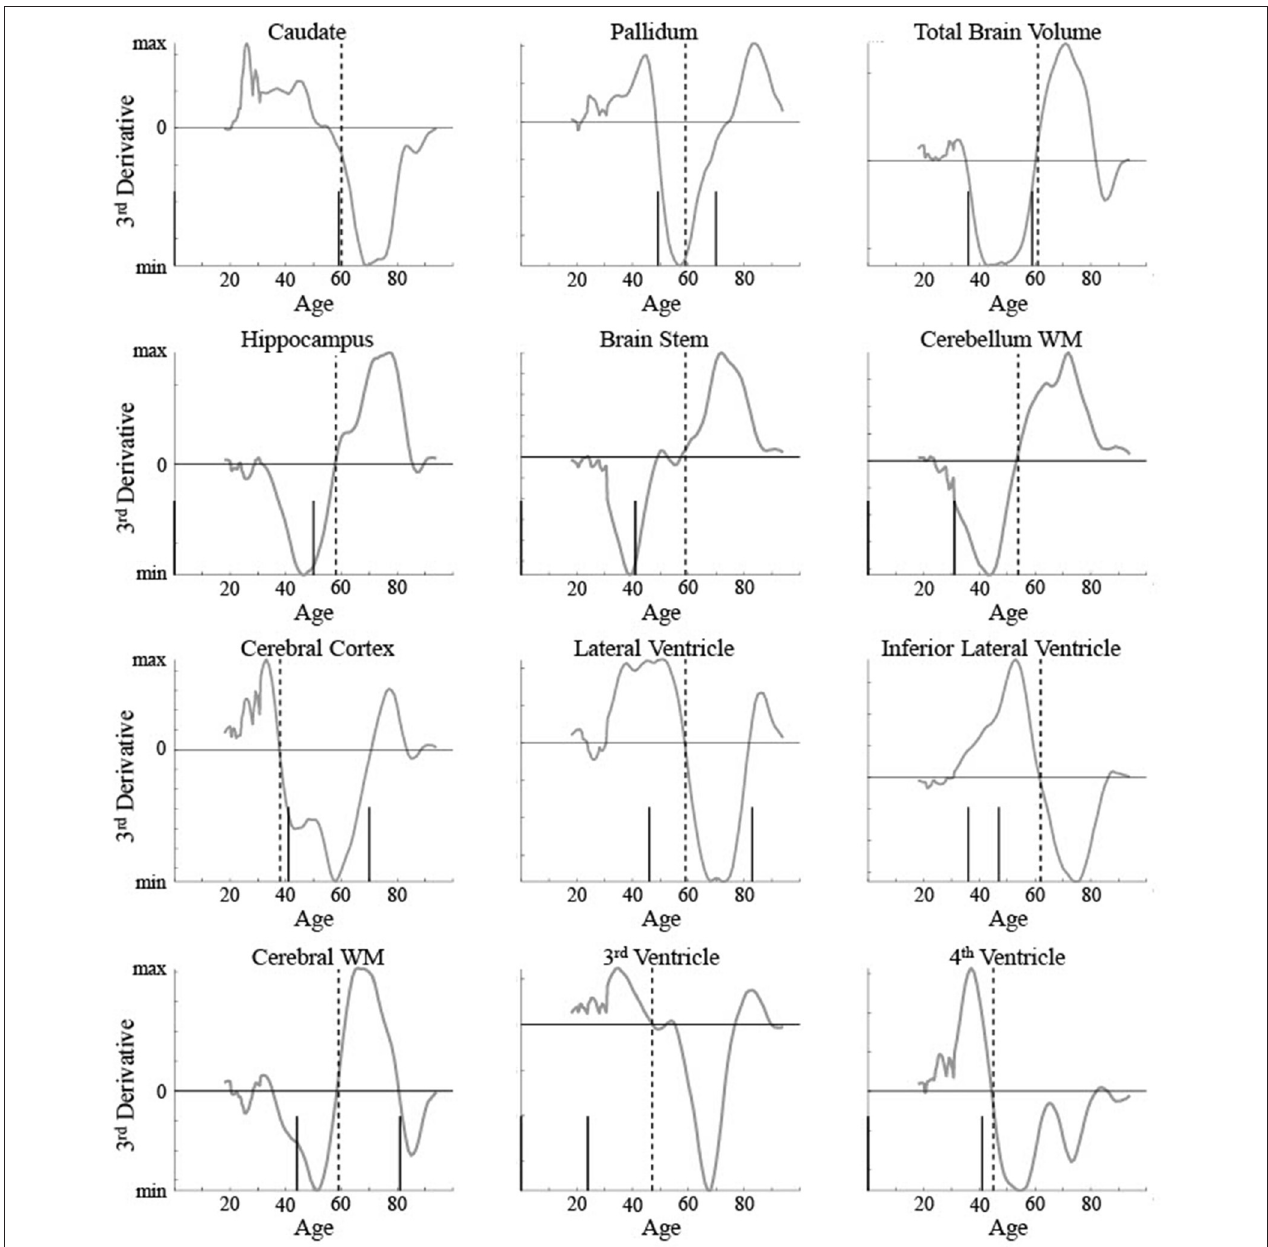
FIGURE 10 | 3rd derivatives for 12 brain measurements (smooth line) are shown along with the determined critical ages (vertical lines) for all measurements classified as non-linear curve types. The upper left measurement (caudate nucleus) was classified as Curve Type 1, the upper middle (pallidum) was classified as Curve Type 2, with the remaining classified as Curve Type 3. Dotted vertical lines show the critical age guess based on the classification procedure. Short solid vertical lines show the critical ages reported in Fjell et al. [3].